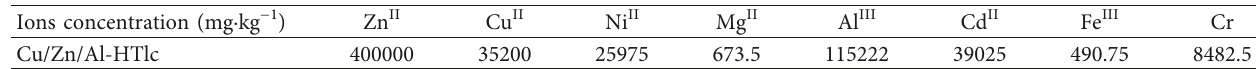
Figure 5: The TG-DTG curve of the Table 2: The metal ions content of Cu/Zn/Al-HTlc.